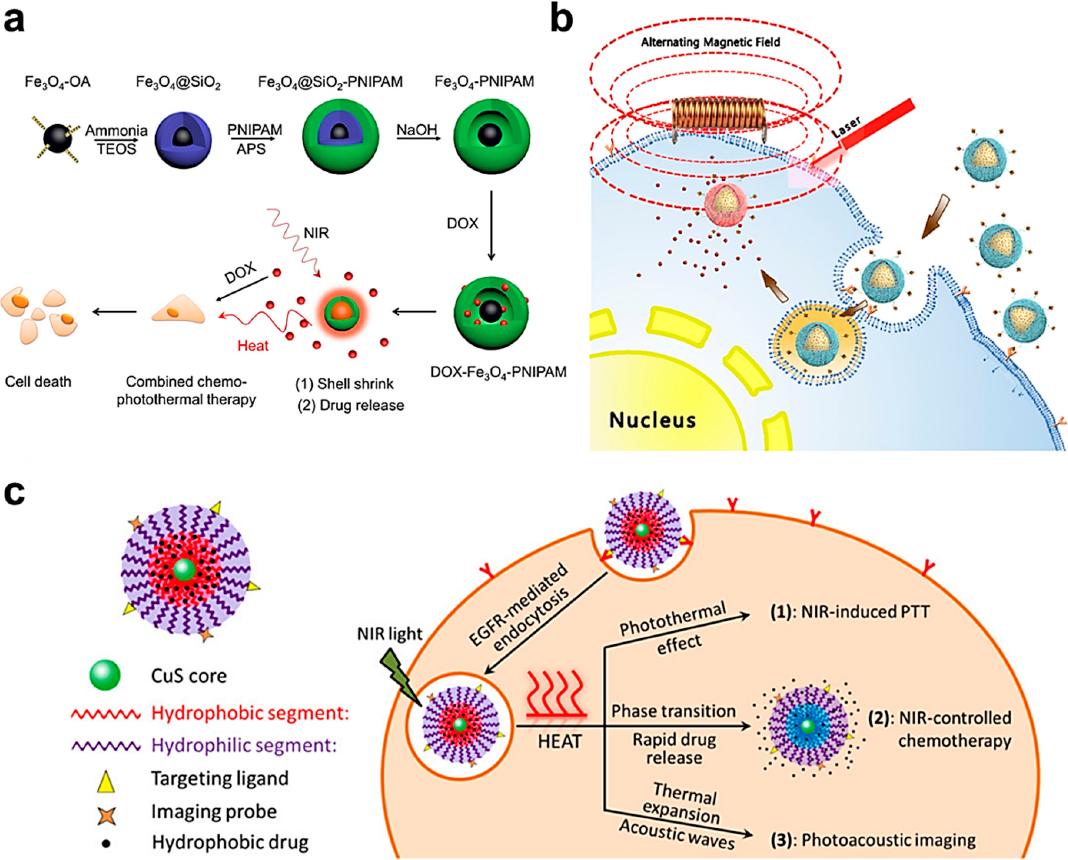
Figure 6. Examples of thermosensitive theranostic nanosystems ( a ) Schematic illustration of the preparation of Fe 3 O 4 -PNIPAm yolk-shell nanocomposites and NIR-trigger drug release. ( b ) Schematic illustration of theranostic functionalities of methotrexate (MTX) modified thermo-sensitive magnetoliposomes (MTX-MagTSLs) loaded with a fluorescent dye Cy5.5 and doxorubicin (Dox). They can achieve dual-imaging effect and provide an appropriate laser irradiation region to release Dox under AMF ( c ) Schematic illustration of a tumor-targeted CuS-based theranostic micelle for combination chemotherapy, photothermal therapy, and photoacoustic imaging. Reproduced with permission from [181,183,187] . Copyright Elsevier, 2017,